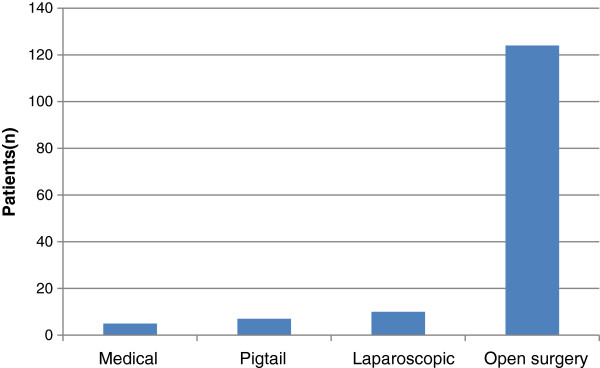
Hospital management.